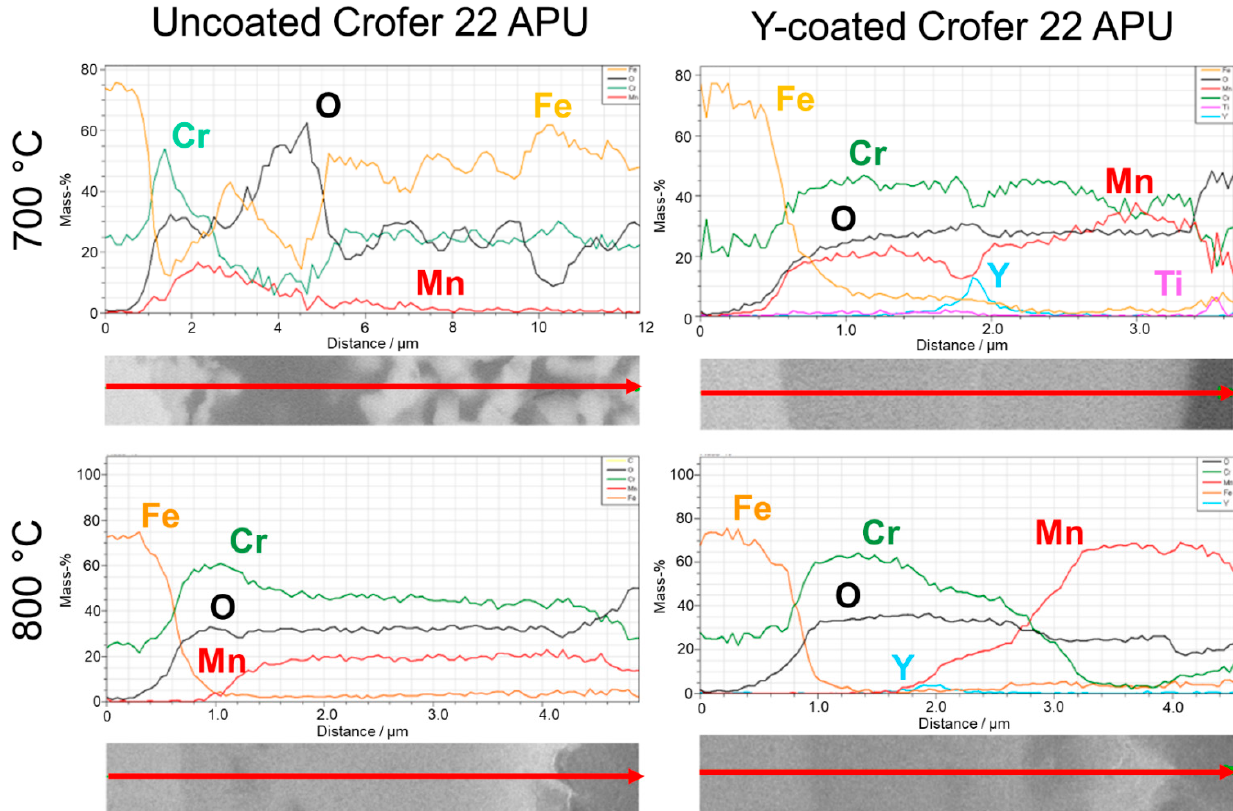
Figure 13. Profile line scans of uncoated Crofer 22 APU ( left ) and Y-coated Crofer 22 APU ( right ) after 1500 h at 700 °C ( top ) and 800 °C ( bottom ) in reducing atmosphere. The red lines in Figure 12 give the places of each.